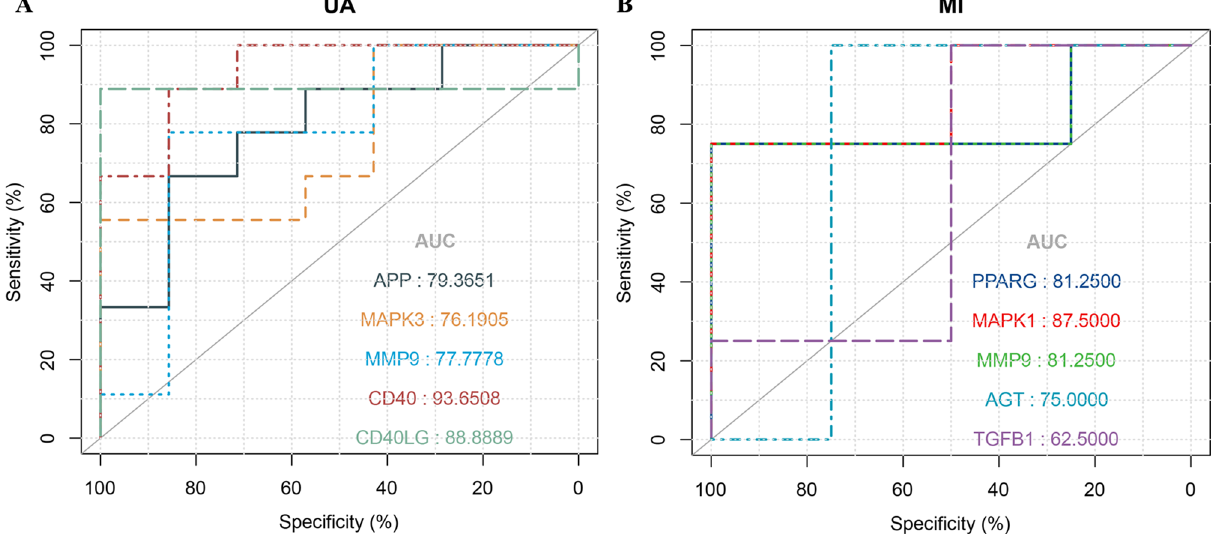
Figure 7. (A) ROC curves of APP, MAPK3, MMP9, CD40 and CD40LG expression in unstable angina. ( B) ROC curves of PPARG, MAPK1, MMP9, AGT, and TGFB1 expression in myocardial